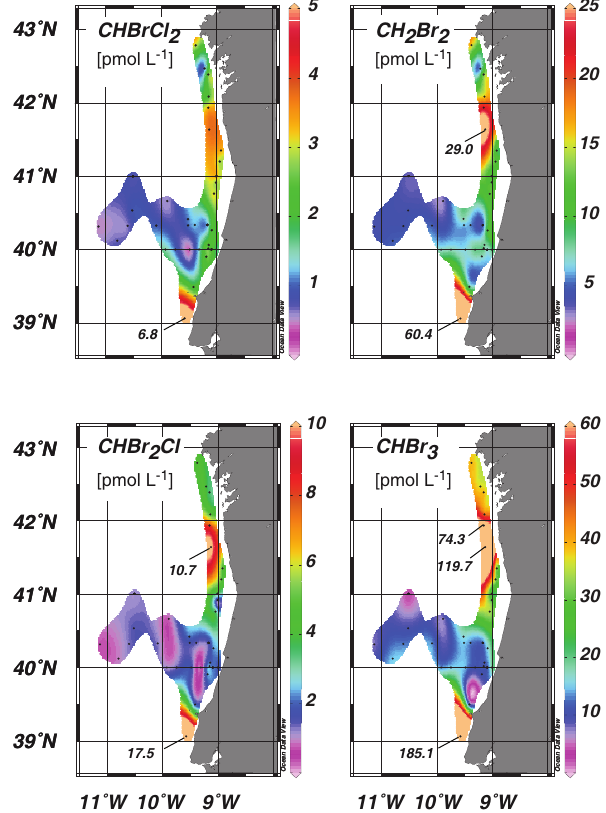
Fig. 3. Sea surface concentrations of bromocarbons in pmoll − 1 . Bromodichloromethane (CHBrCl 2 ) , dibromomethane (CH 2 Br 2 ) , dibromochloromethane (CHBr 2 Cl) and bromoform (CHBr 3 ) . Colour scales indicate different concentration ranges. Stations with values out of scale are labelled. Black dots are CTD